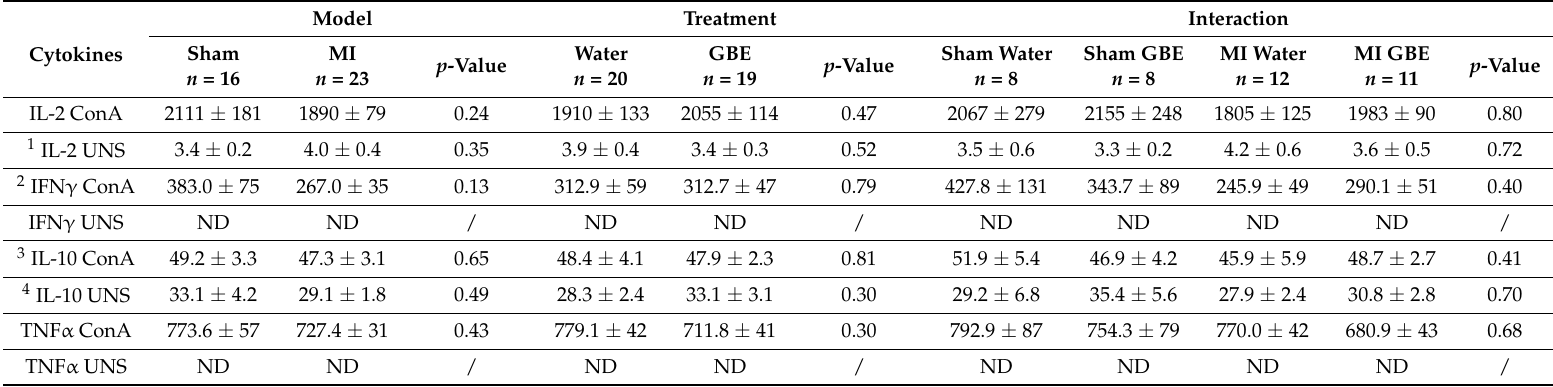
Table 4. Supernatant cytokine concentrations from concanvalin A-stimulated and unstimulated splenocytes. Model Treatment Interaction Sham Cytokines n = 16